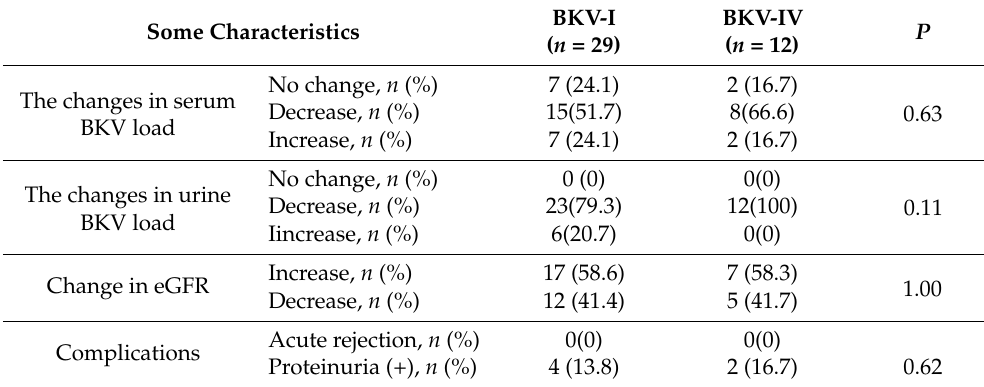
Table 7. Six-month follow-up outcomes in BKV-infected patients according to BKV genotype. Some